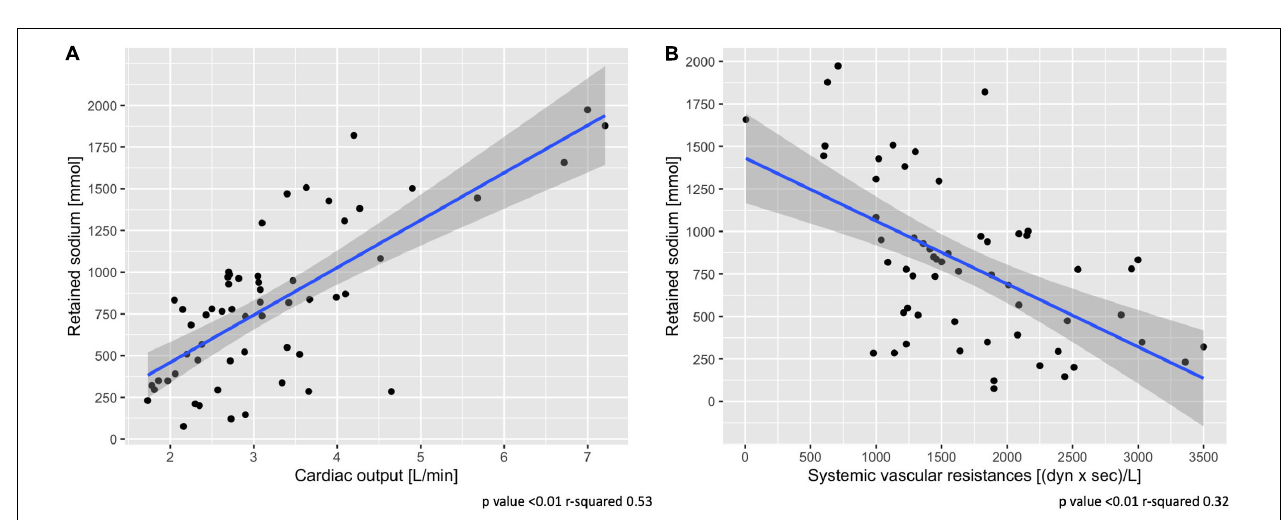
FIGURE 3 | Association between sodium retention and cardiac output (A) and systemic vascular resistances (B) . Scatter-plot of measures obtained at 48 h. Statistic: linear logistic regression. Data available in 58 animals for cardiac output and vascular